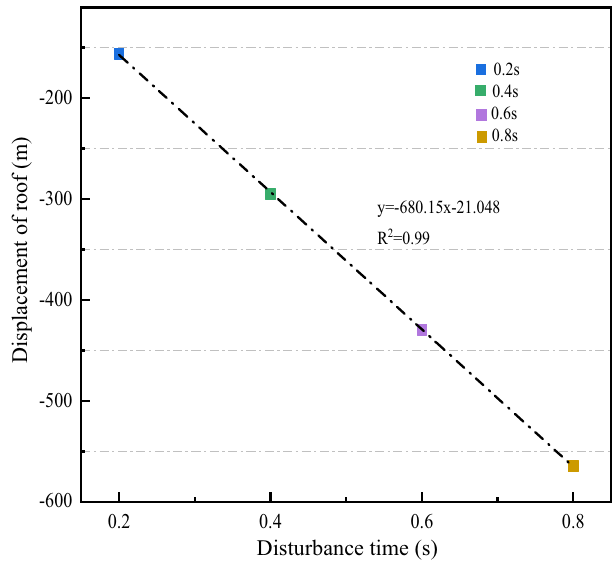
Figure 12. Fitting curve of different disturbance time and roof displacement.